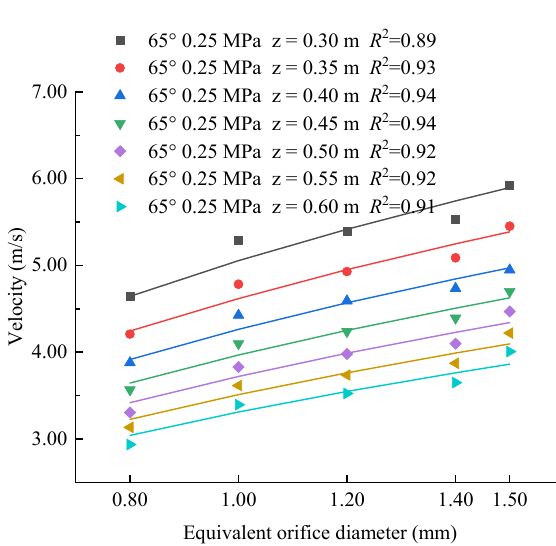
Figure 12. Fitting curves of droplet velocity vs. equivalent orifice diameter. The droplet velocity model along the Z-axis (Equation (19)) was obtained from Equations (16)–(18). The value of coefficient C u was 40, which was obtained by measuring the droplet velocity of nozzle 6504 at 0.15 MPa.